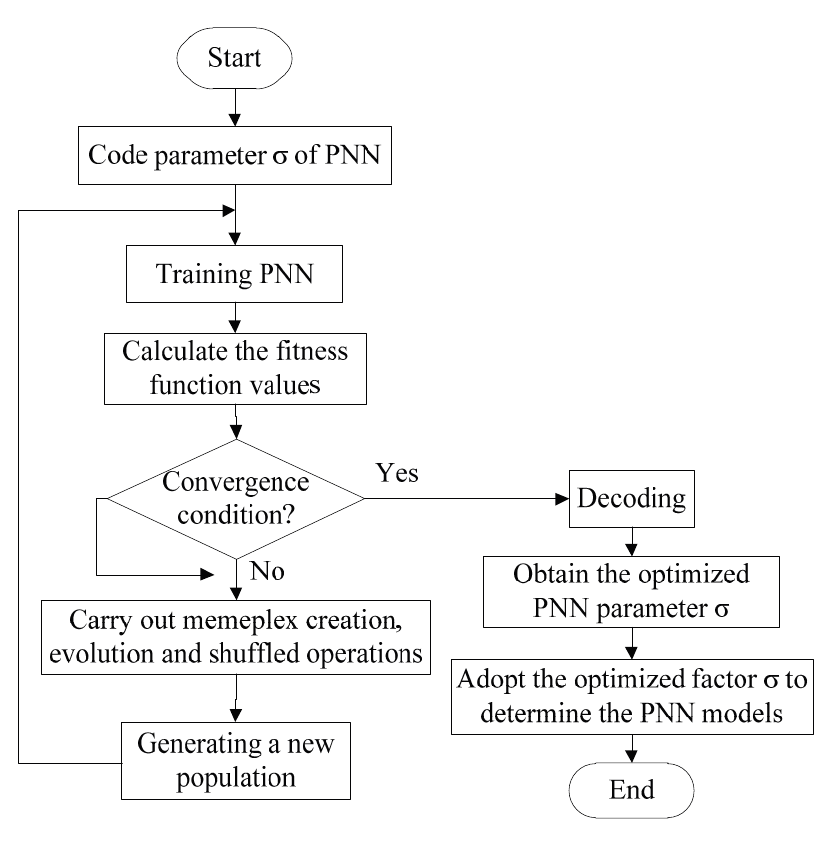
Figure 7. Flowchart of PNN optimized by